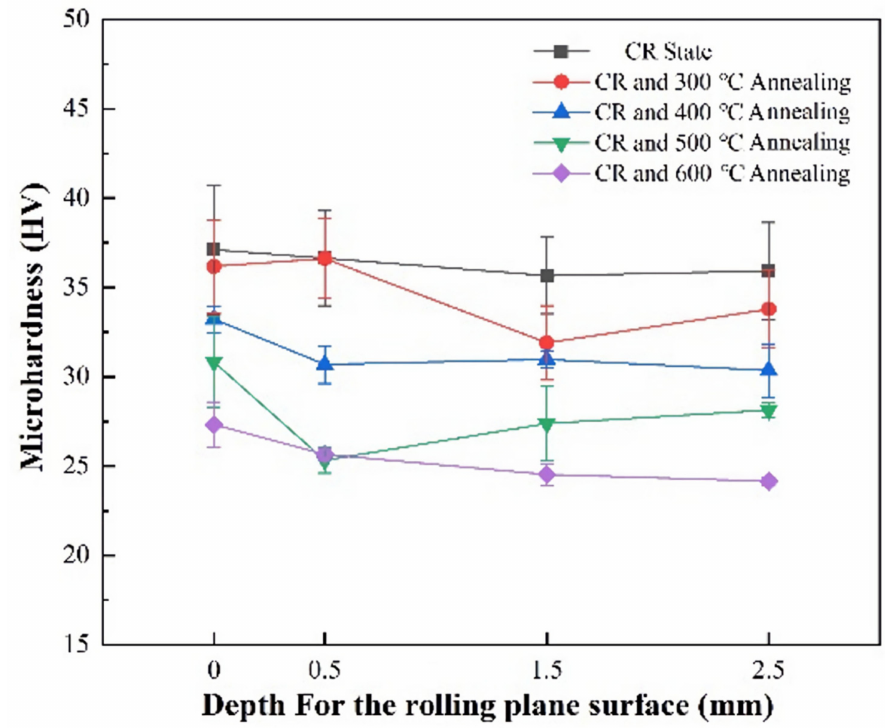
Figure 3. The hardness distribution of Ag with depth from the rolling plane